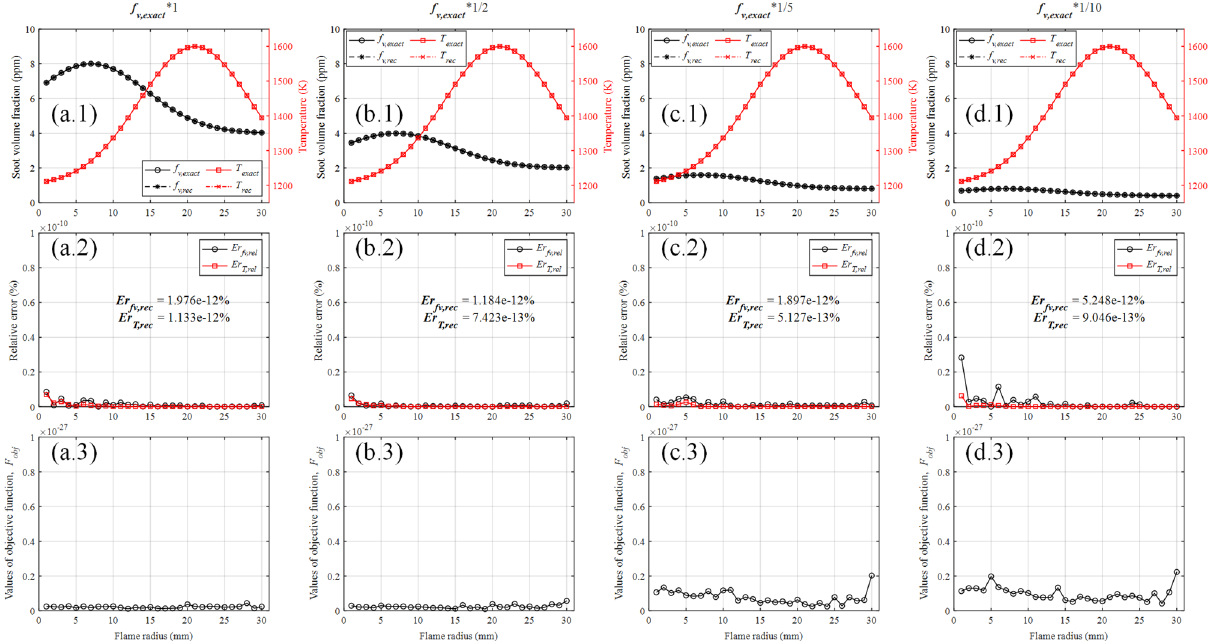
Figure 7. The reconstructed results with optically thin condition. ( a – d ) The input soot concentration field was decreased to 1, 1/2, 1/5 and 1/10 times of the original,